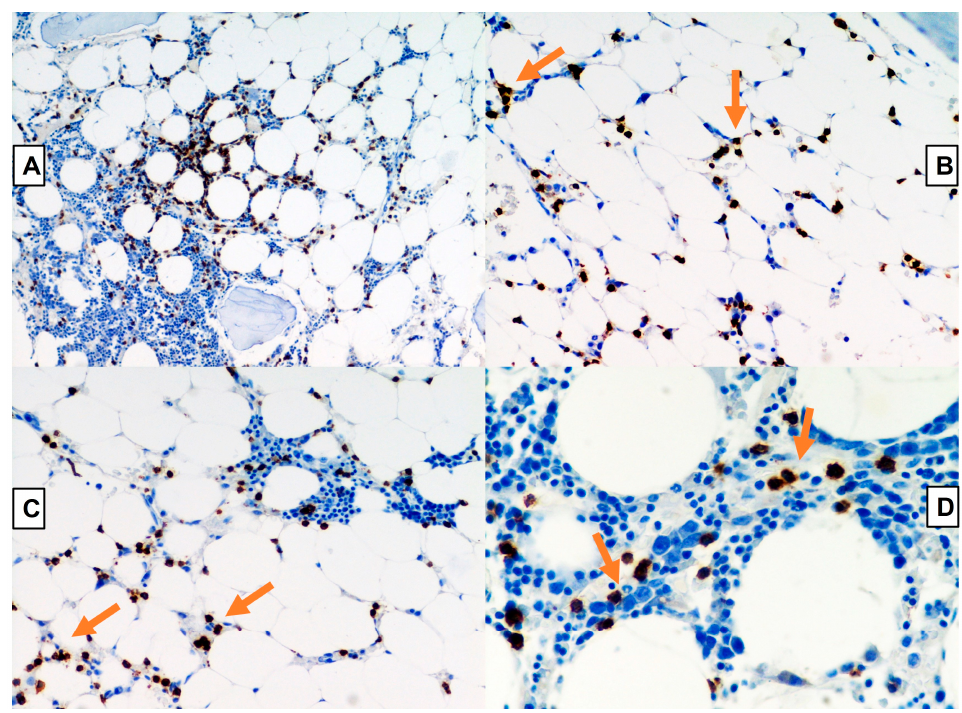
Figure 3. Remarkably hypocellular bone marrow. ( A , B ) Hematoxylin-eosin, original magnification 100 × . ( C ) Immunoreactivity for CD3, immunohistochemistry, 100 ×. ( D ). Immunoreactivity for CD8, immunohistochemistry, 100 × .